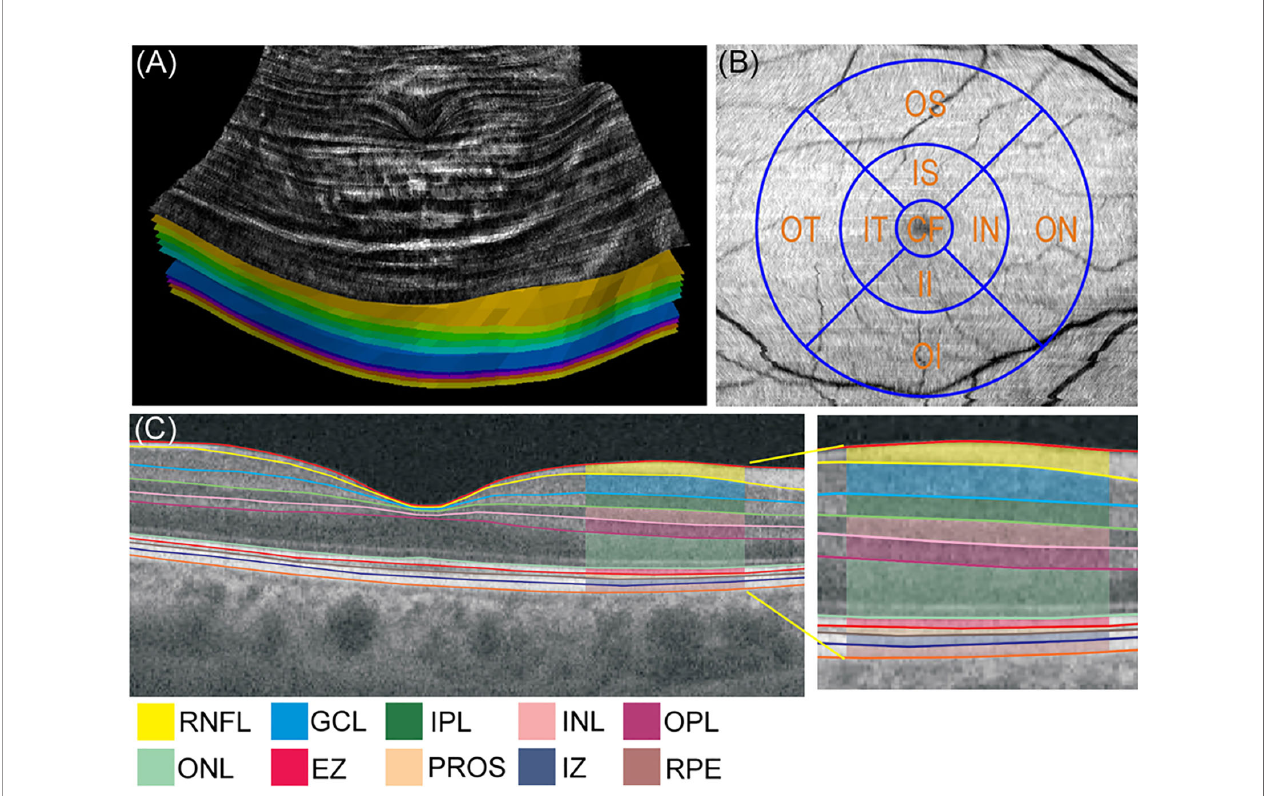
FIGURE 1 | (A) Enface thickness image generated by OCT-Explorer of control subject. The innermost layer was inner limiting membrane, and the outermost layer was retinal pigment epithelium. (B) Three concentric circles of 1, 3, and 6 mm diameter and 9 Early Treatment Diabetic Retinopathy Study grids. (C) Representative optical coherence tomography (OCT) image presenting the mean thickness of macular neuroretinal layers and retinal pigment epithelium in control subject visualized by swept-source OCT and OCT-Explorer. CF, central fovea; EZ, ellipsoid zone; GCL, ganglion cell layer; II, inner inferior; IN, inner nasal; INL, inner nuclear layer; IPL, inner plexiform layer; IS, inner superior; IT, inner temporal; IZ, interdigitation zone; OI, outer inferior; ON, outer nasal; ONL, outer nuclear layer; OPL, outer plexiform layer; OS, outer superior; OT, outer temporal; PROS, photoreceptor outer segment; RNFL, retinal nerve fi ber layer; RPE, retinal pigment